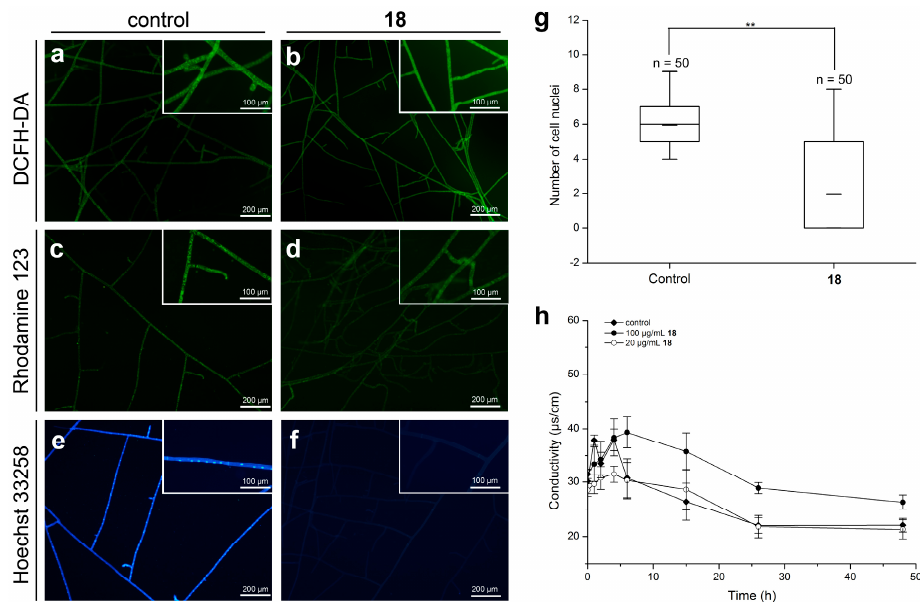
Figure 7. The mode of action of compound 18 against R. solani . ( a , b ) Fluorescent micrographs of the hyphae stained with DCFH-DA to assess endogenous reactive oxygen species (ROS) production; ( c , d ) fluorescent micrographs of the hyphae stained with Rhodamine 123 to evaluate mitochondrial membrane potential (MMP); ( e , f ) nuclear morphology of the hyphae stained by Hoechst 33258; ( g ) the number of nuclei per cell of somatic hyphae treated with 0 or 50 µ g/mL 18 ; ( ** p < 0.01); ( h ) the conductivity of the hyphae suspensions during different time exposure to 18 was measured to assess cell membrane permeability.